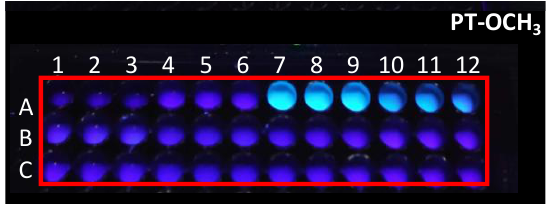
Figure 12. Dependence of the emission spectra of the PT-OCH 3 on different pH environments. Photograph illustrates the fluorescence intensity of the PT-OCH 3 compound in acetonitrile under a UV-LED lamp with a maximum emission of 365 nm in an environment of various pH values: A1 – A3